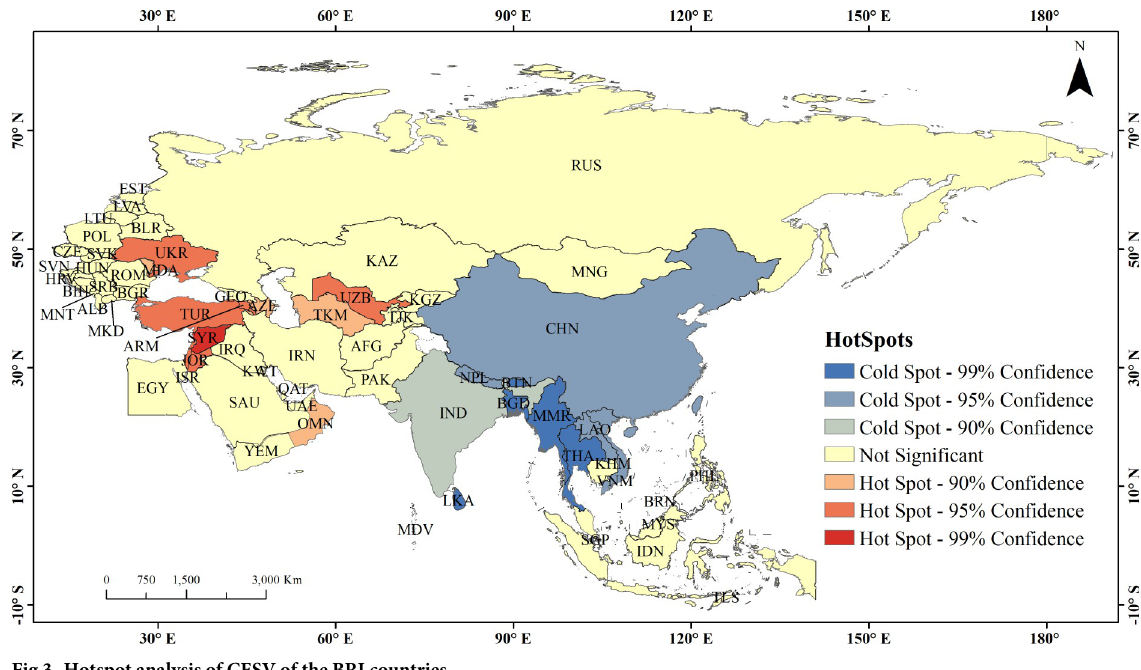
Fig 3. Hotspot analysis of CESV of the BRI